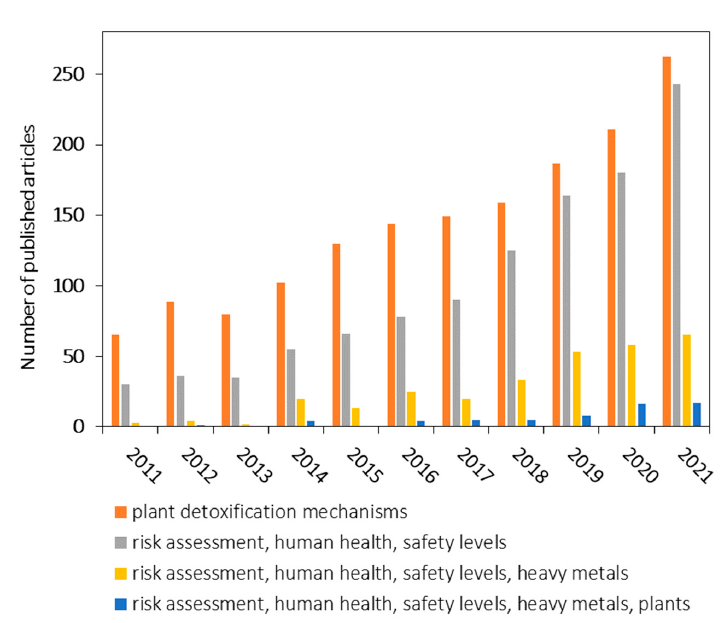
Figure 1. A structured literature review according to data from Web of Science database comprising of the link between plant detoxification mechanisms and the risks posed to human health given the safety levels of heavy metals in plants.